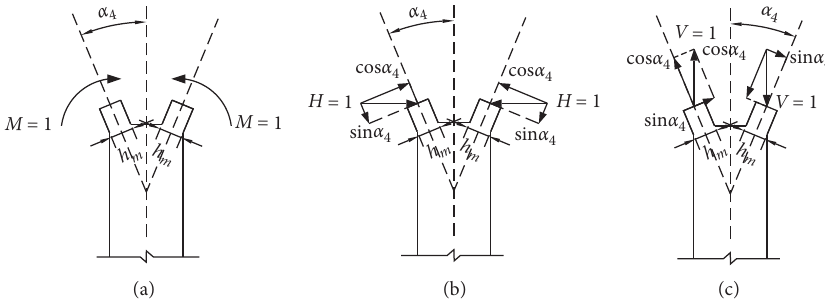
Figure 29: The schematic diagram of the top of the middle wall under the unit load: (a) M � 1; (b) H � 1; (c) V �